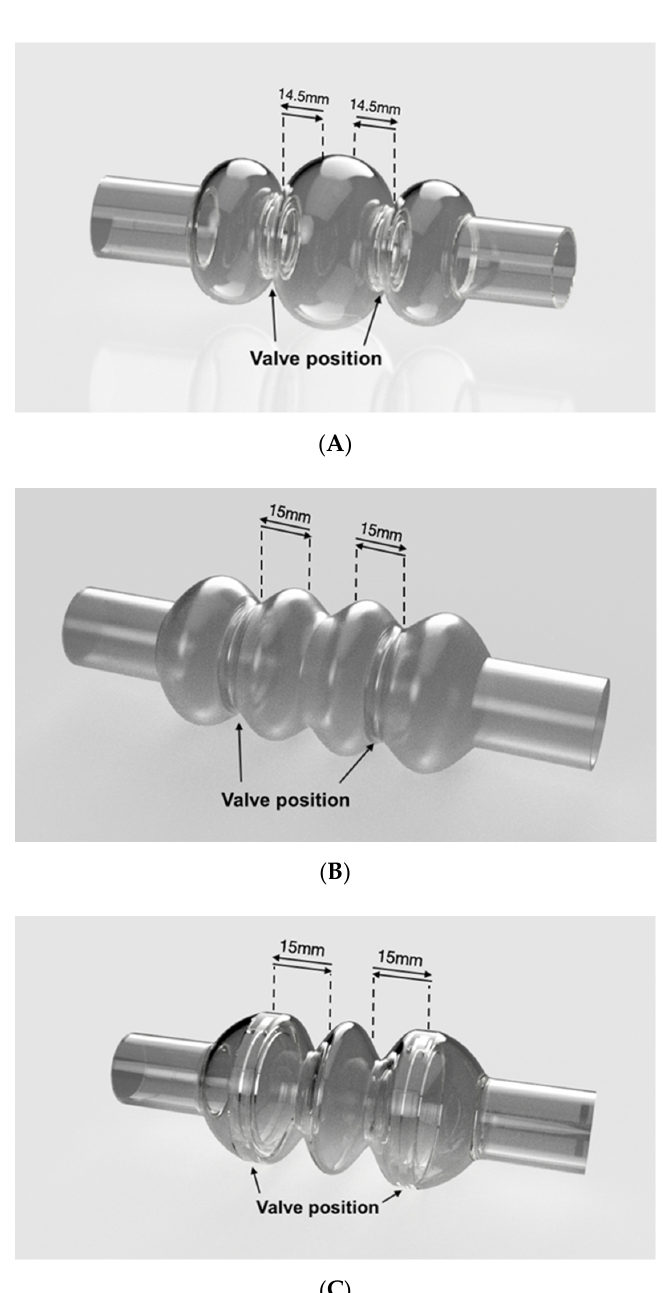
Figure 1. Simulated ventricular chambers: ( A ), ( B ), and ( C ) reproduce the geometric models of the three simulated configurations. Arrows indicate the displacement of the rigid plates (Model A and Model B) or the valve positions (Model C). Valve displacement is set at 14.5 mm for Model A, and 15 mm for Model B and Model C.